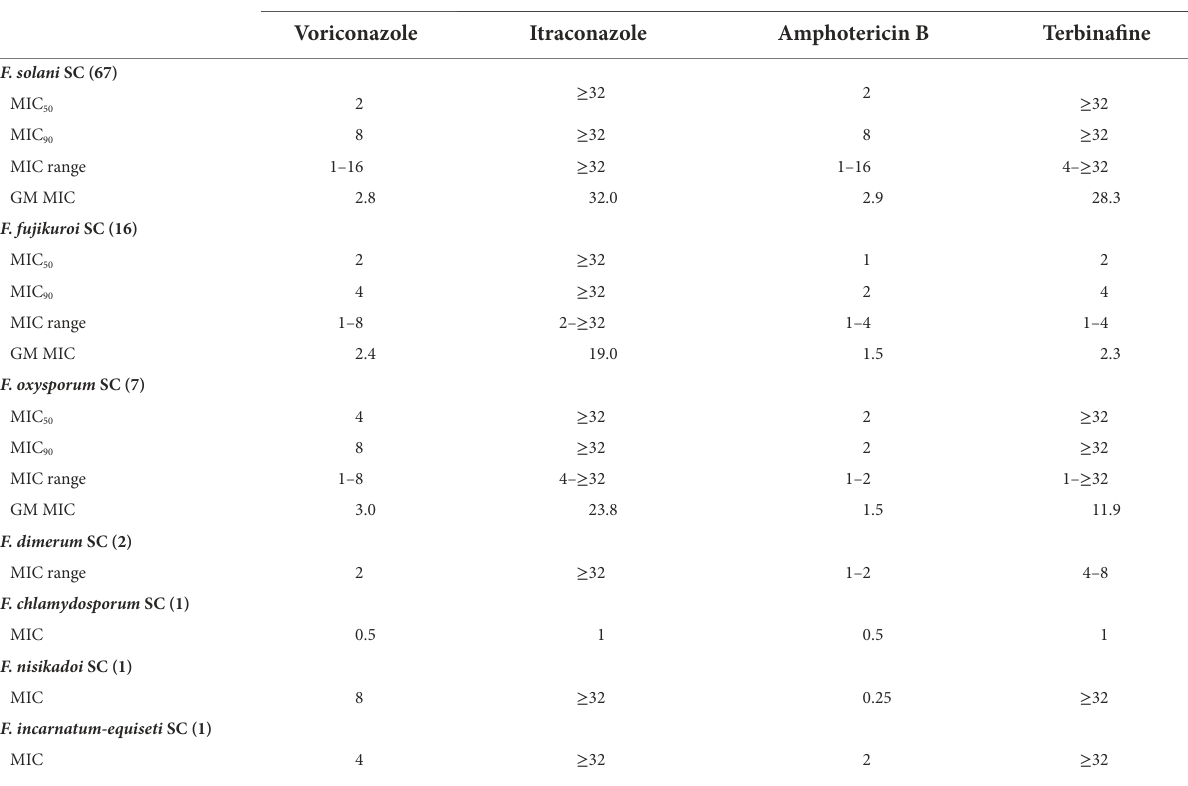
TABLE 2 Activities of antifungal agents against seven Fusarium species complexes (SC). SC